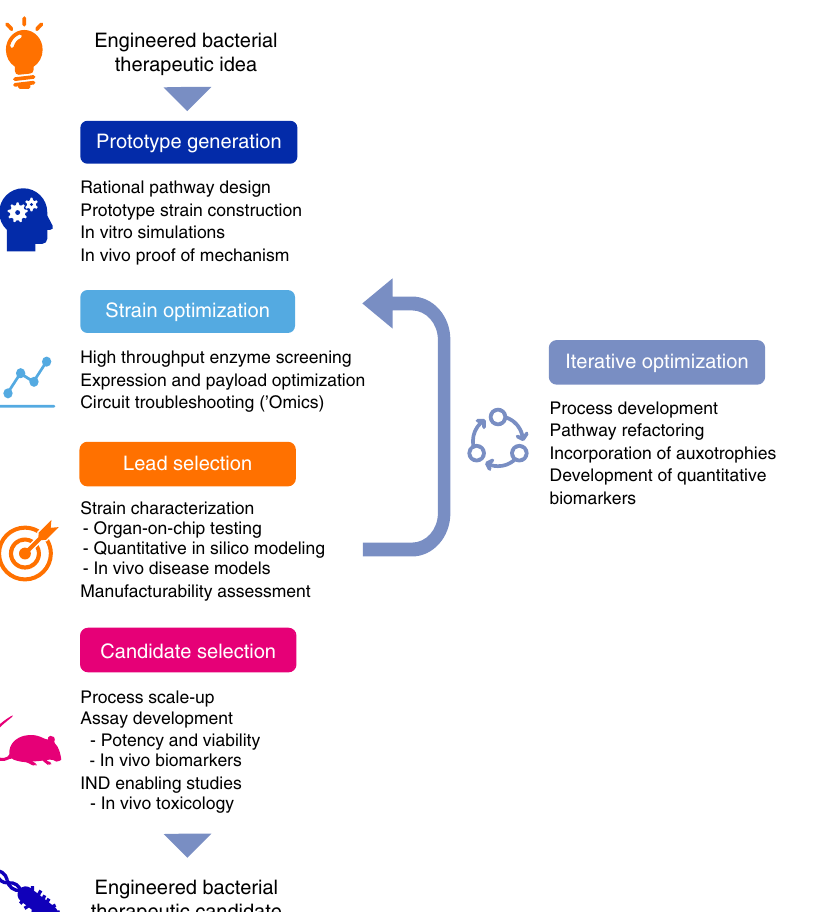
Fig. 2 Strategy for the development of engineered live bacterial therapeutic clinical candidates. Schematic representation of a work fl ow for developing clinical candidate-quality engineered strains. The development work fl ow should incorporate technologies for optimizing strain potency, as well as predictive in vitro and in vivo assays, as well quantitative pharmacology models, to maximize translational potential for patient